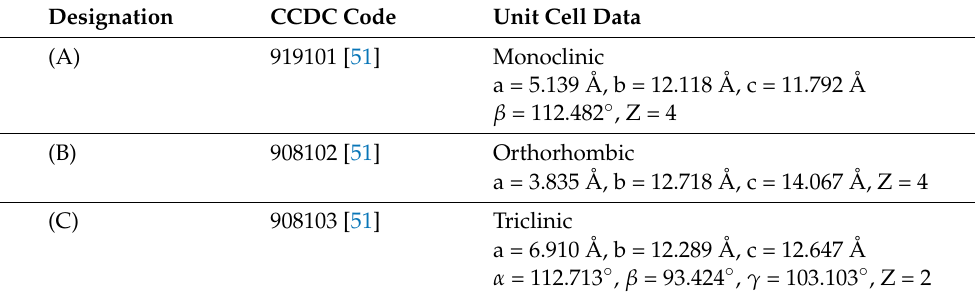
Table 1. CCDC code and unit cell data for the investigated